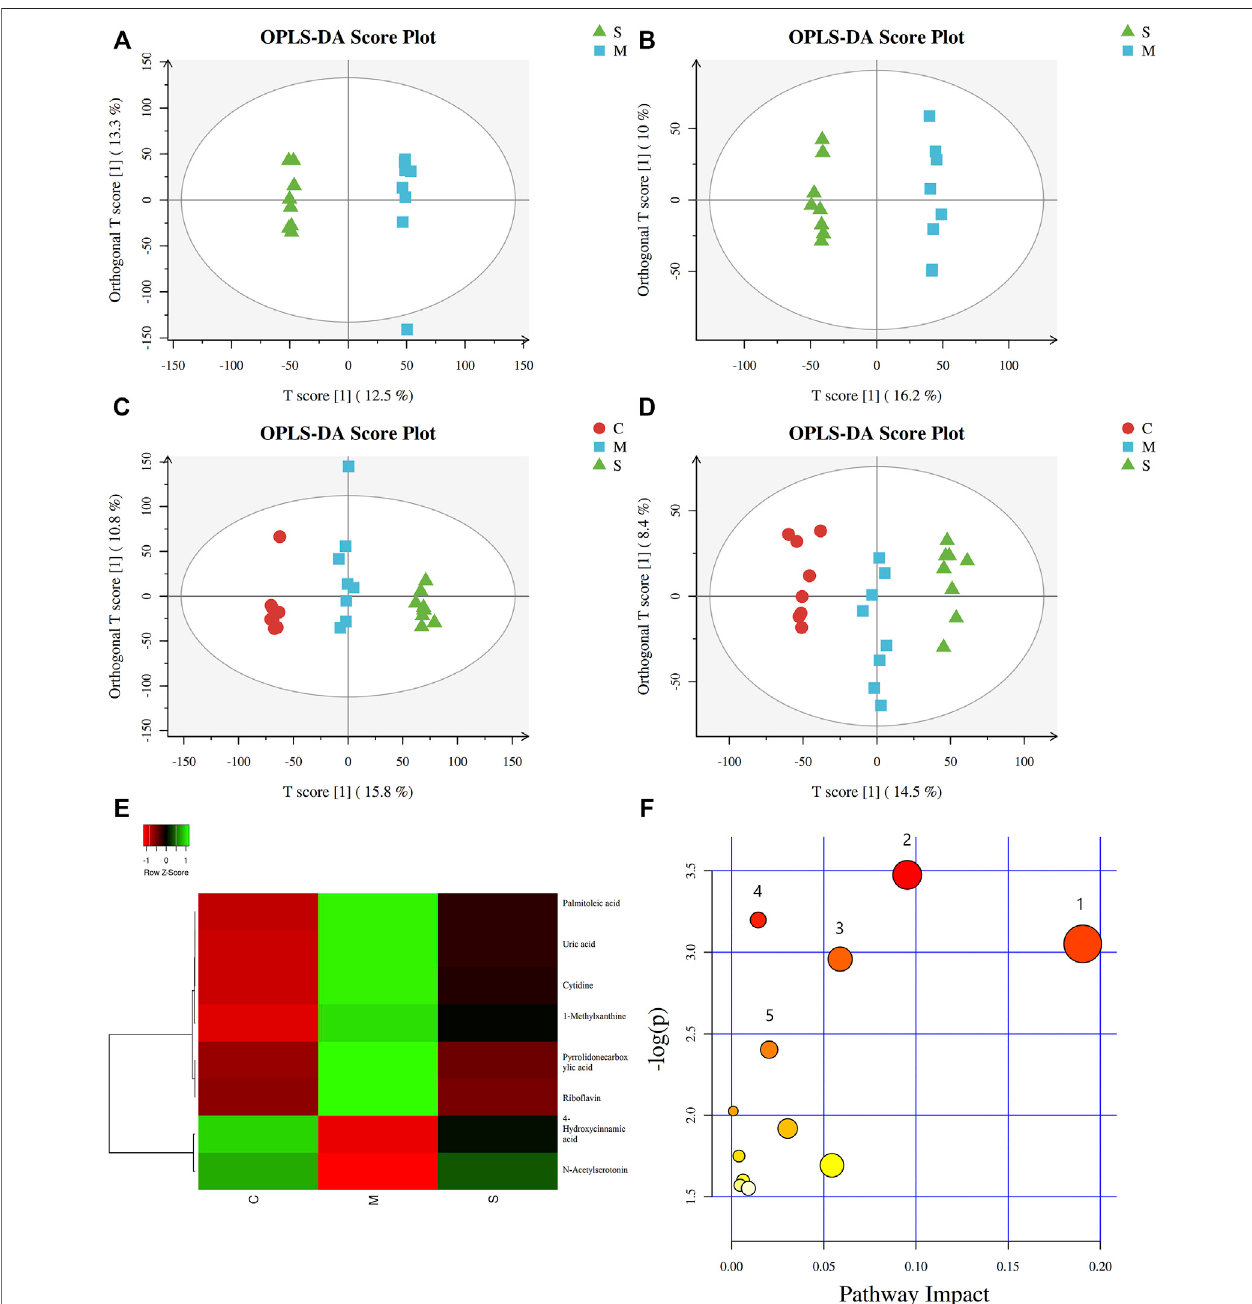
FIGURE3| Metabolic pro fi lesofserum samplesinratswithSHLtreatmentinmodelgroups. (A) OPLS-DAscoreplotinpositivemode betweenmodel groupsand SHL medium-dose groups (R 2 Y = 0.999 and Q 2 Y = 0.653); (B) OPLS-DA score plot in negative mode between model groups and SHL medium-dose groups (R 2 Y = 0.995andQ 2 Y=0.780); (C) OPLS-DAscoreplotinpositivemodebetweennormalcontrolmodel,modelgroupsandSHLmedium-dosegroups(R 2 Y=0.995andQ 2 Y= 0.888); (D) OPLS-DAscoreplotinnegativemodebetweennormalcontrolmodel,modelgroupsandSHLmedium-dosegroups(R 2 Y=0.984andQ 2 Y=0.839); (E) Clustering heatmaps of differential metabolites between the normal control (CG), model (MG), and SHL medium-dose groups (ZG). Green represents high adjacency (positive correlation), and red represents low adjacency (negative correlation); (F) Metabolic pathway analysis of differential metabolites between the model groups (MG) and SHL medium-dose groups